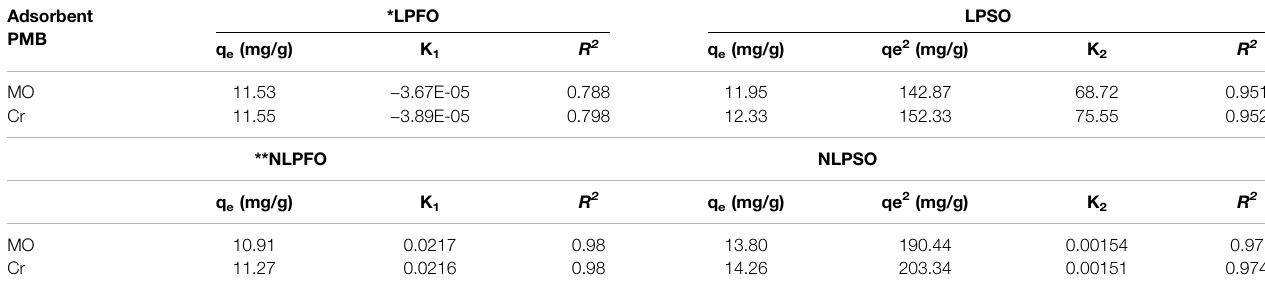
TABLE 3 | Pseudo – fi rst-order and pseudo – second-order kinetic model parameter values. Adsorbent PMB